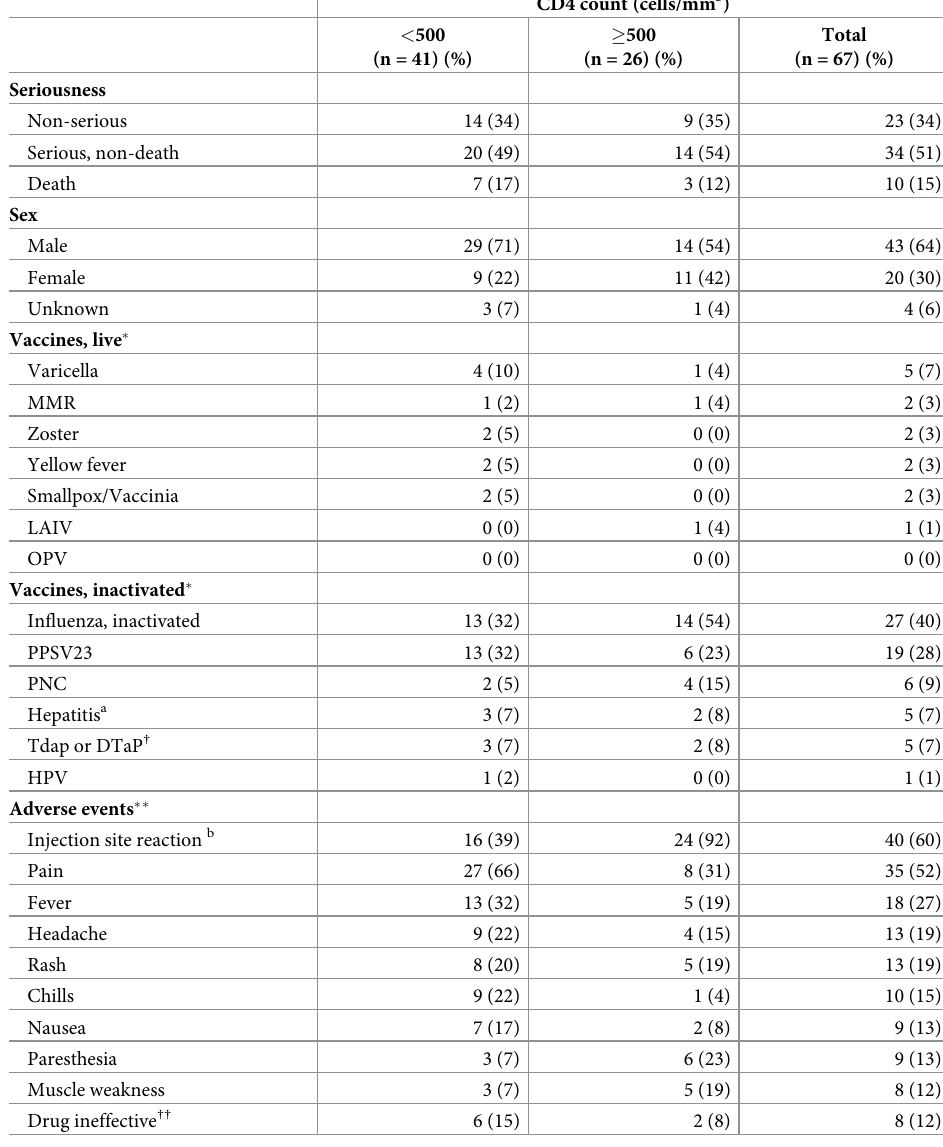
(cid:3) Includes both vaccines administered singly, and concomitantly with other vaccines; MMR = combination